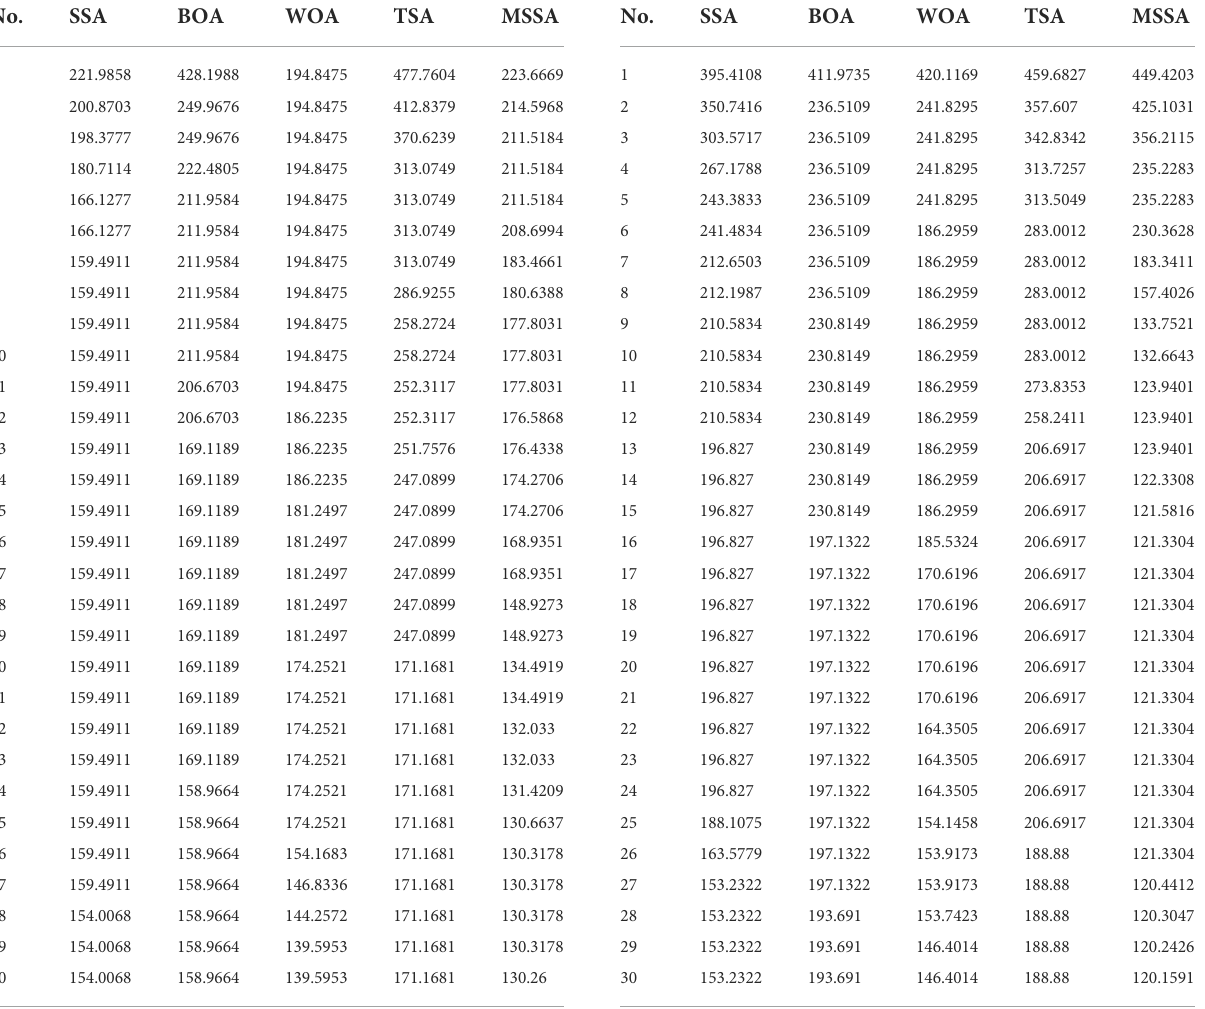
TABLE 7 Experimental data of environment 1. TABLE 8 Experimental data of environment